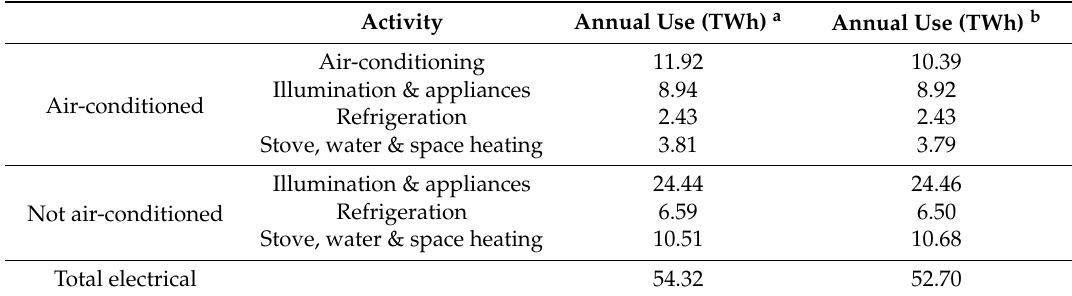
Table 5. Annual national use of the Mexican residential sector in 2015. a Study presented in this paper. b Calculation from refs.